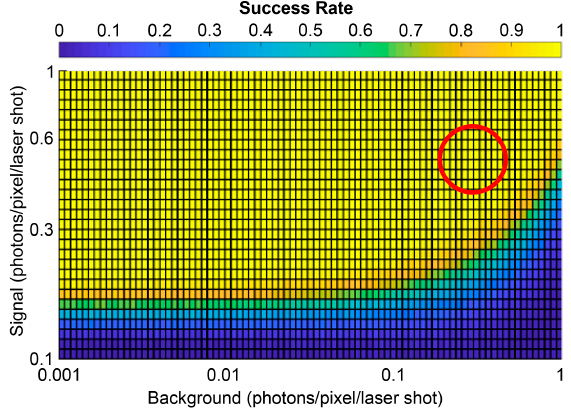
Figure 13. Monte Carlo simulation showing the success ratio in considering an SPAD within the spot as a function of the signal detection rate and the background detection rate. The red circle shows the region with 0.52 signal photons and 0.32 background photons per laser shot per SPAD.